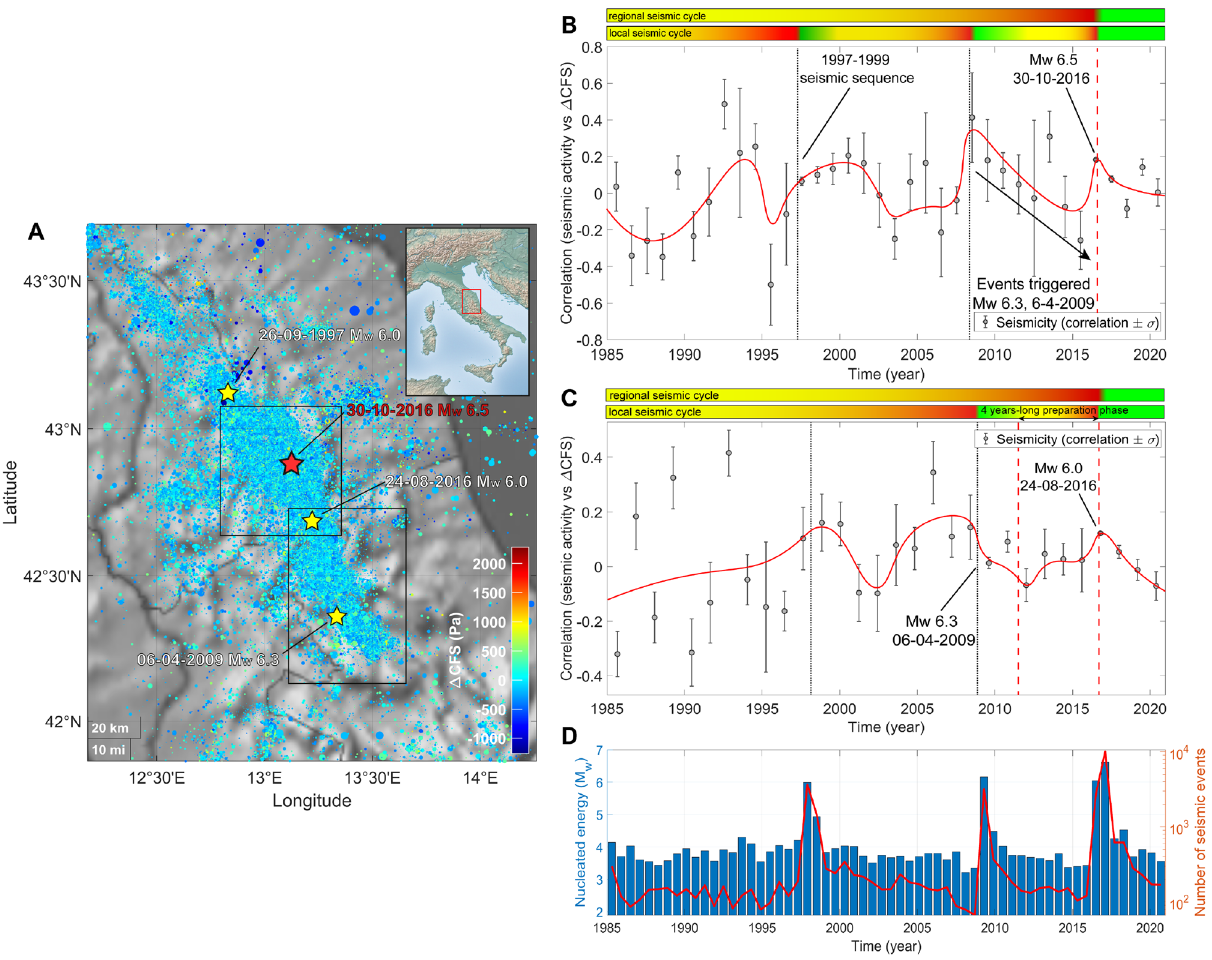
Figure 4. ( A ) (cid:31) CFS map for seismicity in Central Italy, INGV Catalog, 1985−2021, M L ≥ 2.0. The map is realized using the functions “geoscatter” and “geobasemap” in the Matlab environment 63 . ( B ) Correlation ρ between (cid:31) CFS and seismicity in the Valnerina area between 1985 and 2021. The plot is realized by taking into account earthquakes happened at latitude 42.7°−43.1° N and longitude 12.9°−13.3° E. Only 5−15 km deep seismic events are considered, M L ≥ 2.0. The red line is a weighted smoothing spline. Two horizontal color bars above the scatter plot show nested “seismic cycles” whose phases are highlighted by different colors (green for the postseismic phase, the interseismic one is in yellow and the coseismic phase is in red). ( C ) Correlation ρ between (cid:31) CFS and seismicity in Central Italy, Monti della Laga and North L’Aquila province, between 1985 and 2021. The plot is realized by taking into account earthquakes happened at latitude 42.2°−42.8° N and longitude 13.1°−13.6° E. Only 0−15 km deep seismic events are considered. ( D ) Histogram of energy nucleated by earthquakes with ML ≥ 2.0 (blue bars) and plot of the number of recorded seismic events (red